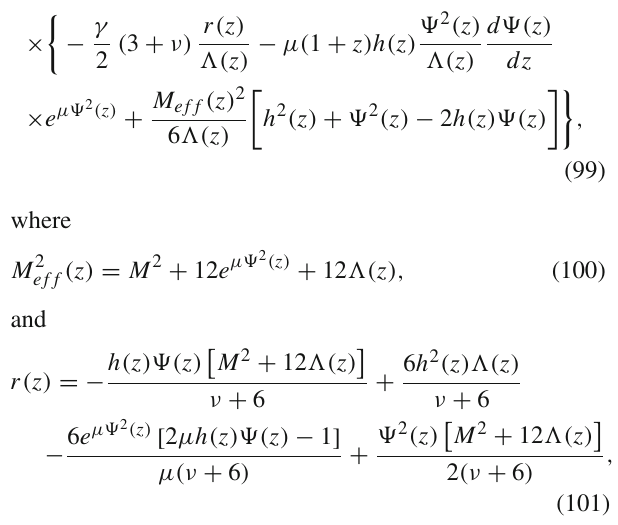
Fig. 10 Variation as a function of the redshift of the dimension- less Hubble function h ( z ) for the geometry-matter coupling function (cid:11) (cid:12) ˜ Q , ˜ T = η e μ ˜ Q / 6 + ν ˜ T for M = 1 . 7, η = 6 /μ , ν = 20, and F for different values of μ : μ = 1 . 7 (dotted curve), μ == 1 . 5 (short dashed curve), μ = 1 . 3 (dashed curve), μ = 1 . 1 (long dashed curve), and μ = 0 . 9 (ultra-long dashed curve). To integrate the system of cosmological evolution equations we have used the initial conditions h ( 0 ) = 1, (cid:18)( 0 ) = 0 . 058, and (cid:4)( 0 ) = 0 . 0235. The solid curve rep- resents the evolution of the Hubble function in the standard (cid:4) CDM cosmological model